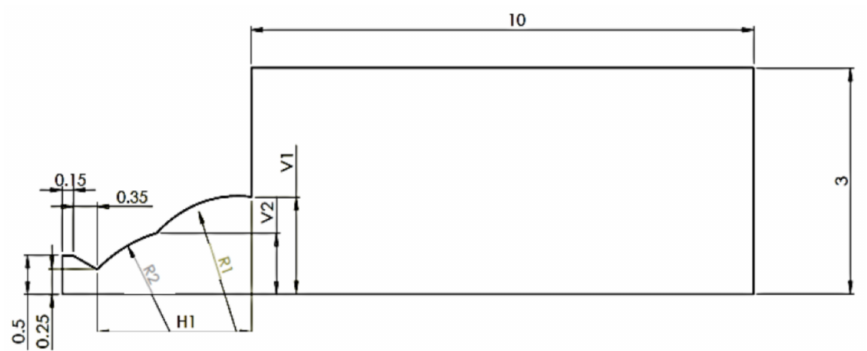
Figure 14. Dual nozzle